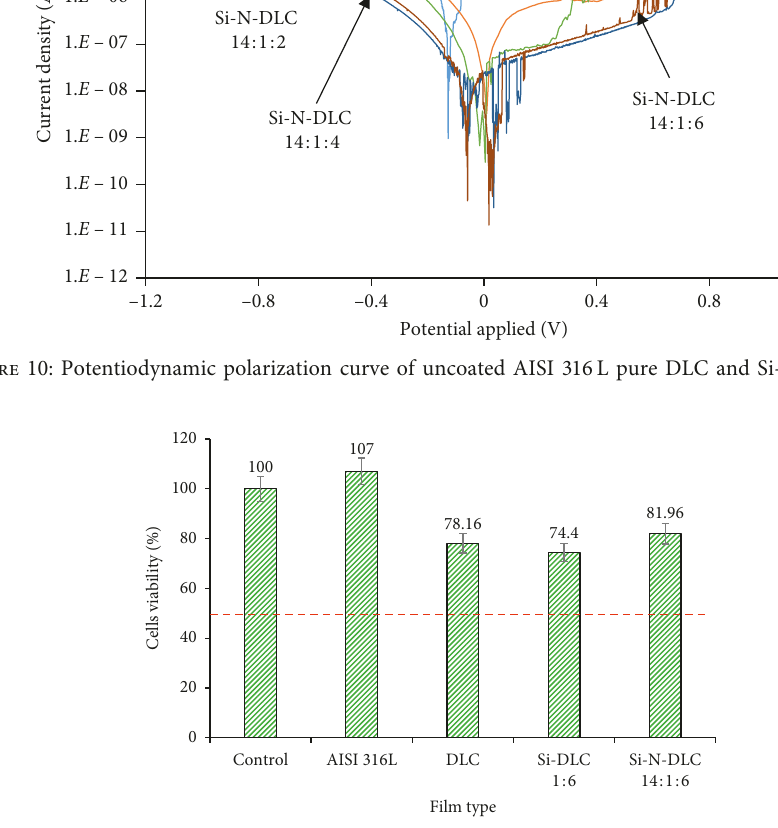
Figure 11: The cells viability of all films by using the DMEM elution